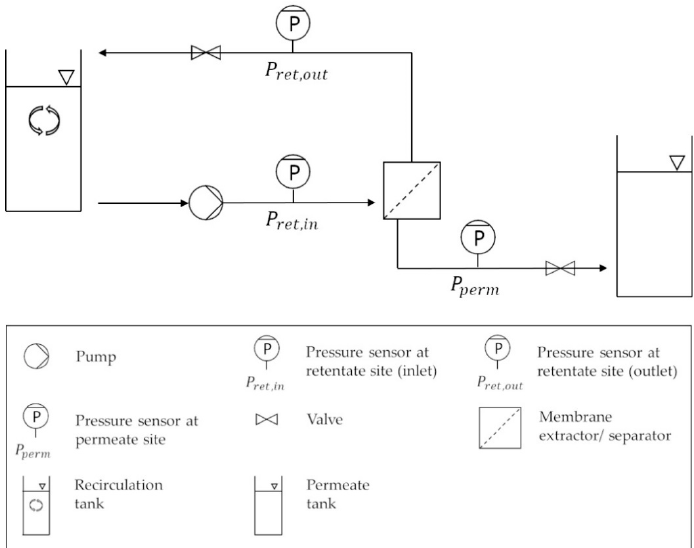
Figure 1. Schematic representation of the setup for phase separation experiments. ATPS